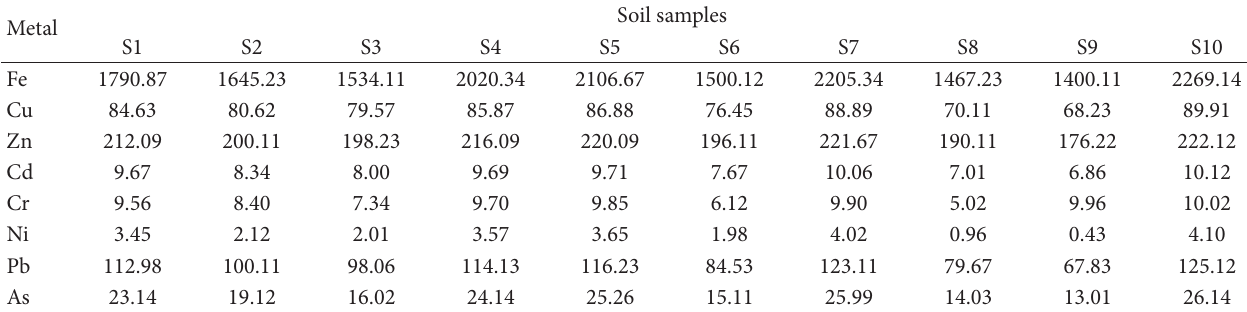
T 4: Heavy metal concentration (mg/Kg) in soil samples—SEM EDX, ICP-OES